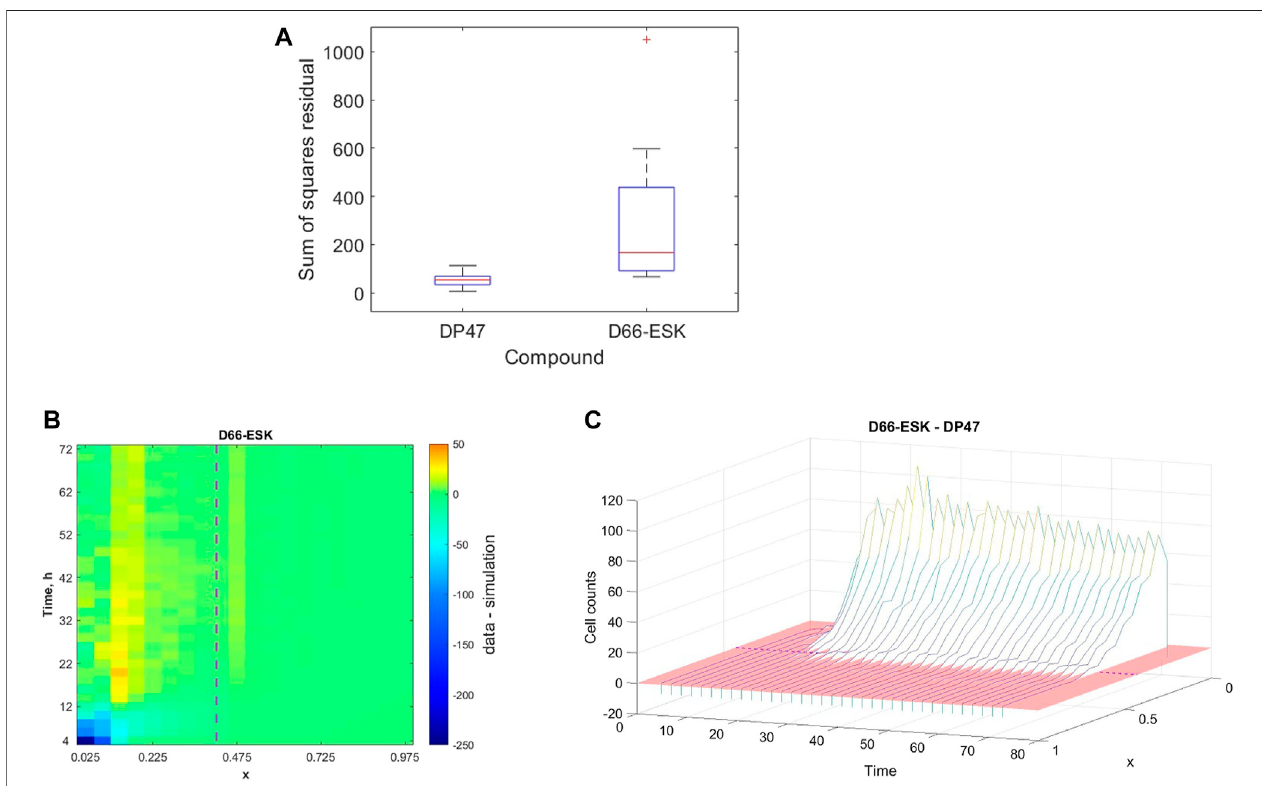
FIGURE7|(A) Boxplotsshowingthedistributionofthebestmodel fi tstothedataacrossallexperimental conditionsseparatedbycompoundbetweenthecontrol TCB, DP47, and the cytotoxic TCB, D66-ESK. (B) Heatmap of the discrepancy between the model simulations and the data for each data point aggregated across all conditions in the presence of D66-ESK. The purple dashed line marks the position of the interface between the middle and top channels. (C) Waterfall plot showing the difference indistributionofin fi ltratingPBMCsateach timepoint betweentheD66-ESKconditionsandtheDP47conditions.Thered regionshowstheplanewhere the difference in cell count is zero. The location of the interface between the middle and top channels of the plate is marked by the purple dashed